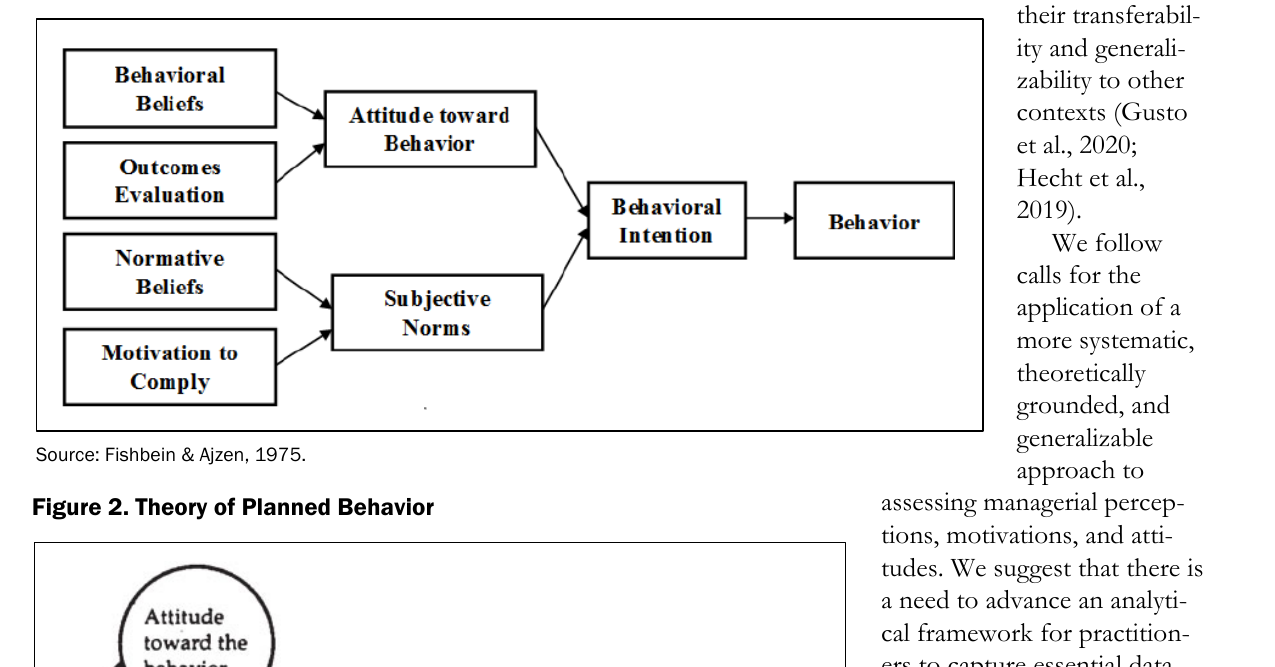
Figure 1. Theory of Reasoned Action